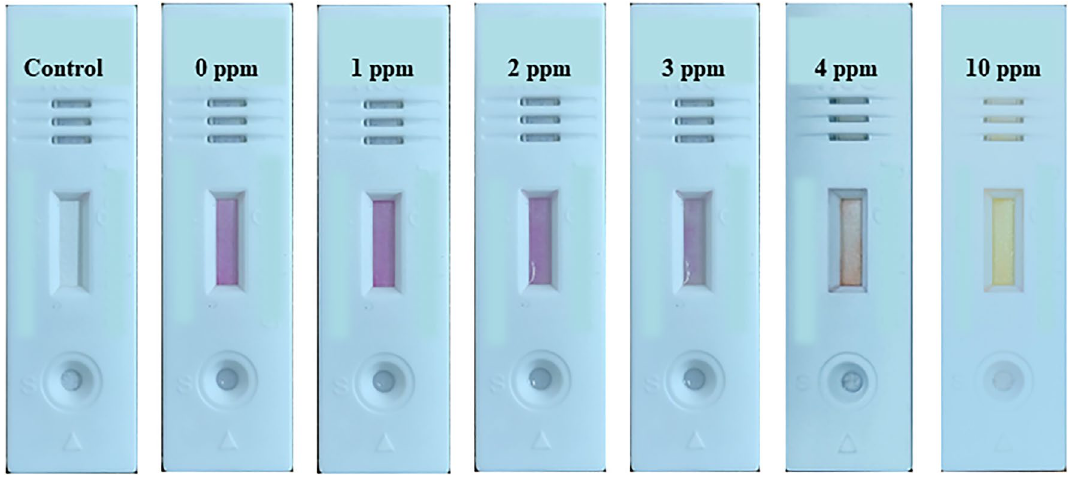
Figure 11. C 1 -based LFA for detection of fluoride in aqueous